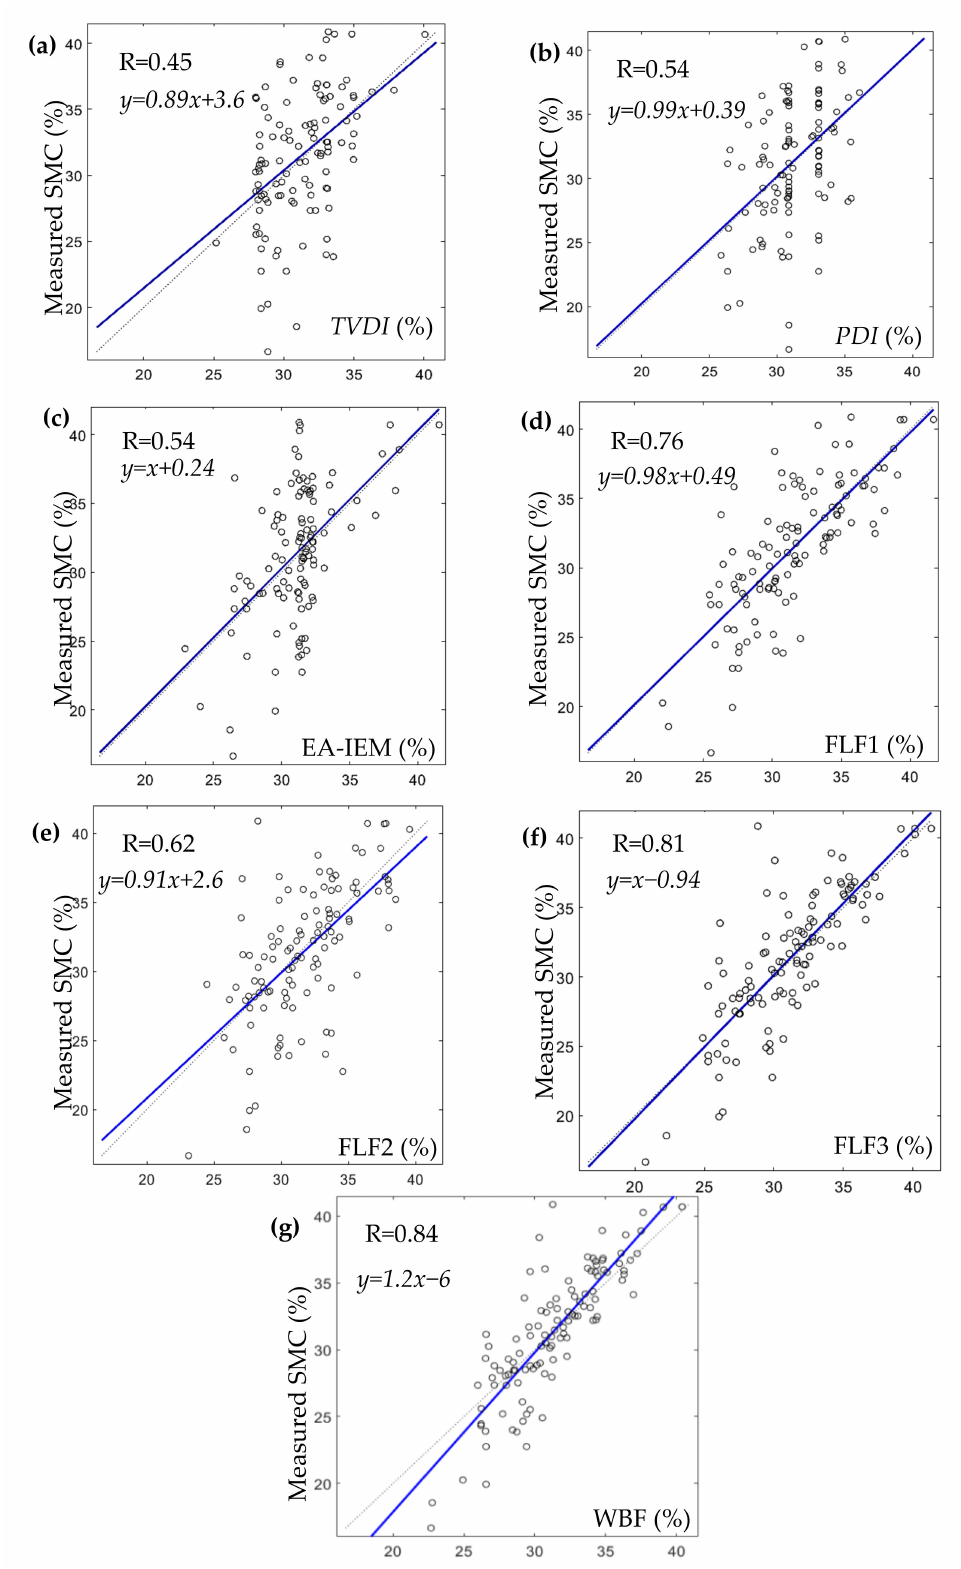
Figure 10. Results of each of the used SMC estimation methods in the Sidi Rached 1 dataset where ( a ). TVDI. ( b ). PDI. ( c ). EA-IEM. ( d ). FLF1. ( e ). FLF2. ( f ). FLF3. ( g ).